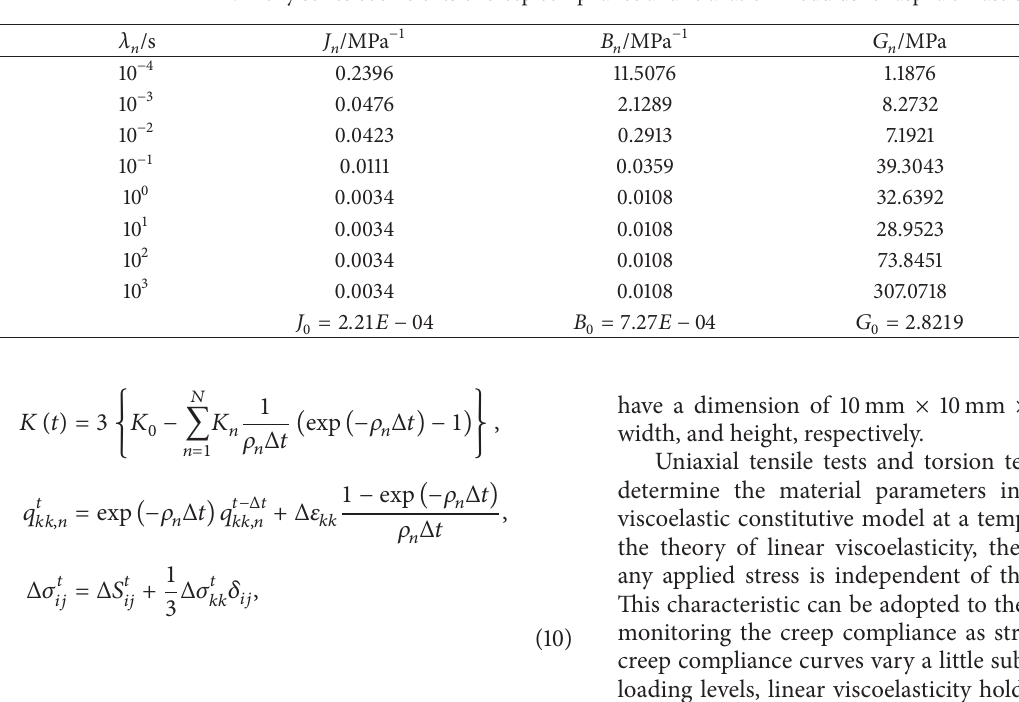
Table 1: Prony series coefficients of creep compliance and relaxation modulus for asphalt